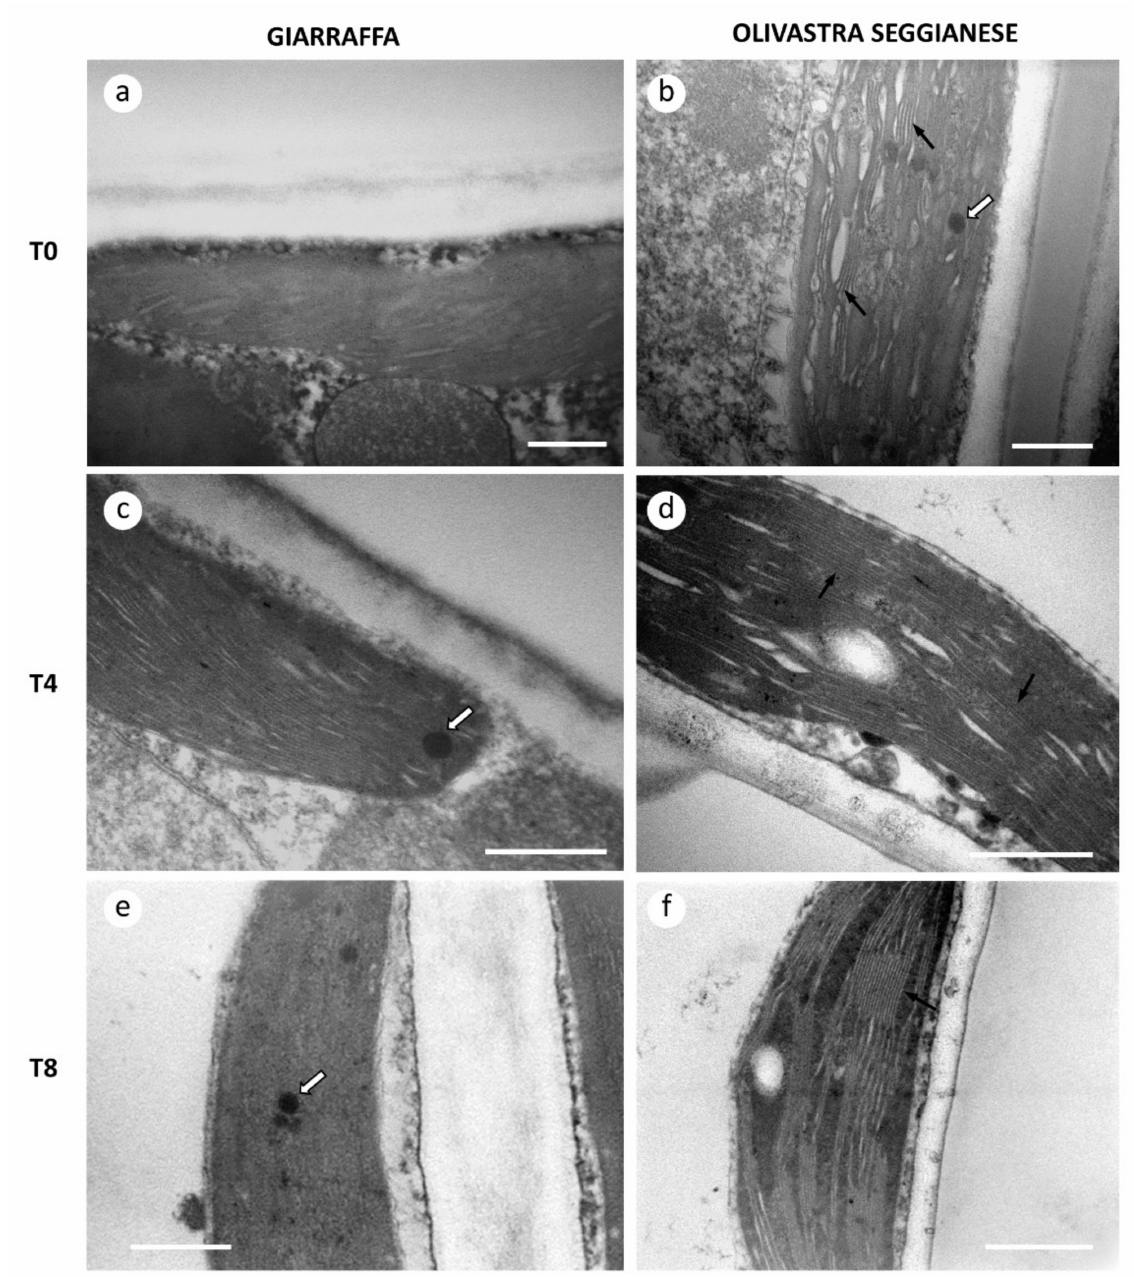
Figure 1. Ultrastructural analysis of chloroplasts of Giarraffa and Olivastra Seggianese leaves. ( a ) Chloroplast in Giarraffa leaves at T0; note the relative compactness of thylakoids. ( b ) Chloroplast in Olivastra Seggianese leaves at T0; thylakoids are more spaced and less compact. ( c ) Chloroplast of Giarraffa at T4, still characterized by a high compactness of thylakoids. ( d ) Chloroplast of Olivastra Seggianese at T4, characterized by a lower compactness of thylakoids. ( e ) Two chloroplasts of Giarraffa at T8, where it is still difficult to distinguish individual thylakoids. ( f ) Ultrastructure of chloroplast of Olivastra Seggianese at T8, with easily distinguishable thylakoids and grana. Black arrows indicate thylakoids, while white arrows indicate lipid bodies. Bars: 500